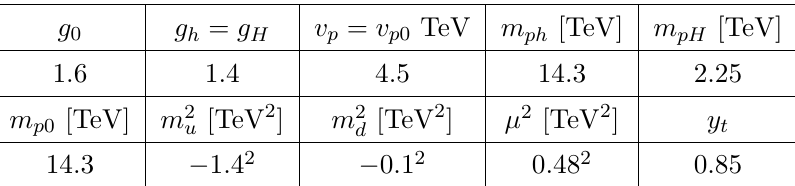
Table 3 . Numerical values of the input parameters used in our study. As the IR scale in our analysis is above a TeV, we use a smaller value of y t than its weak-scale value to account for running e(cid:11)ects. The only source of Z 2 breaking between the two sides of our tower are the soft masses of the P (cid:12)elds.